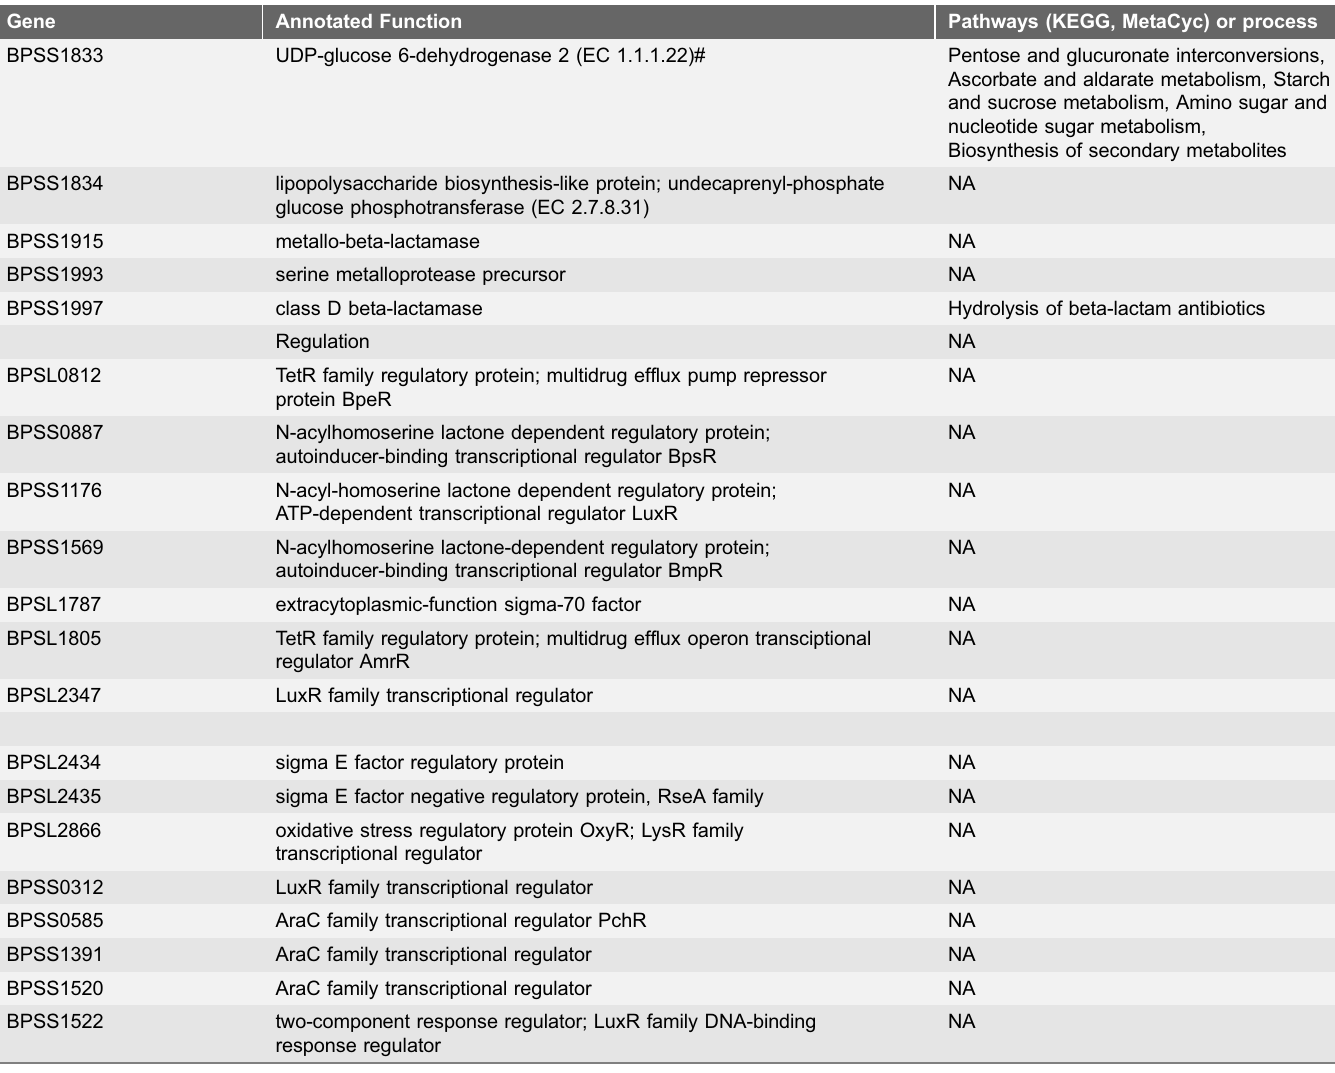
Table 7. Cont. Gene